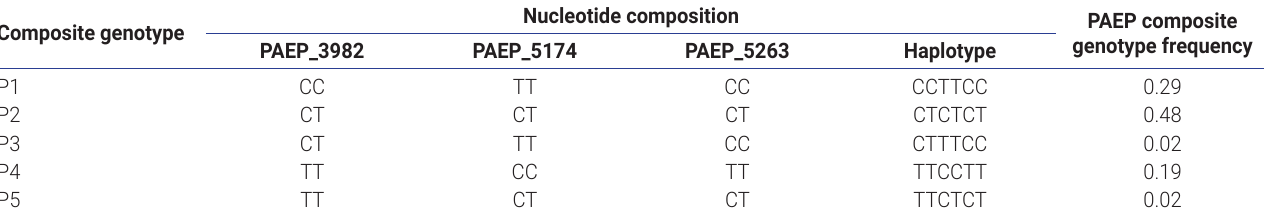
Table 3. Progestogen-associated endometrial protein composite genotype frequencies (%) Composite